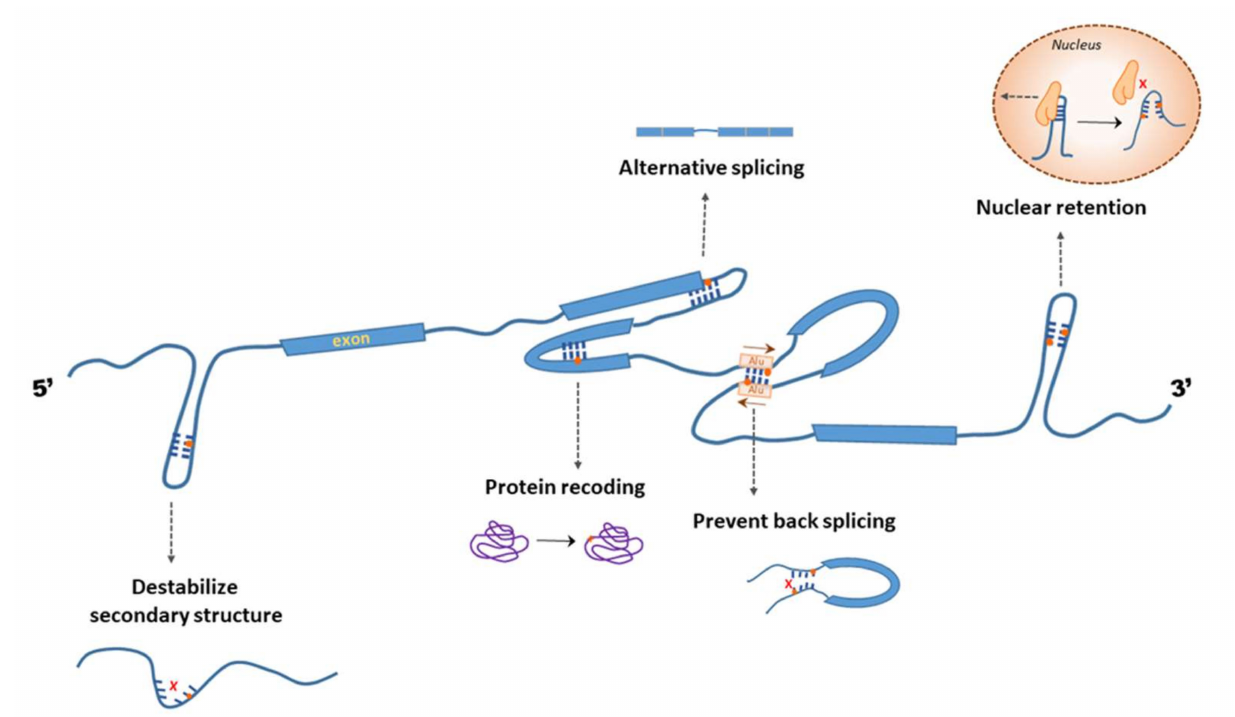
Figure 6. A-to-I editing in mRNAs. The effects of A-to-I editing in different regions of a hypothetical mRNA are shown. Inosine modification in the coding regions may result in protein recoding. Inosines from the untranslated regions modulate the secondary structure of mRNA, thus affecting the localization, stability, and